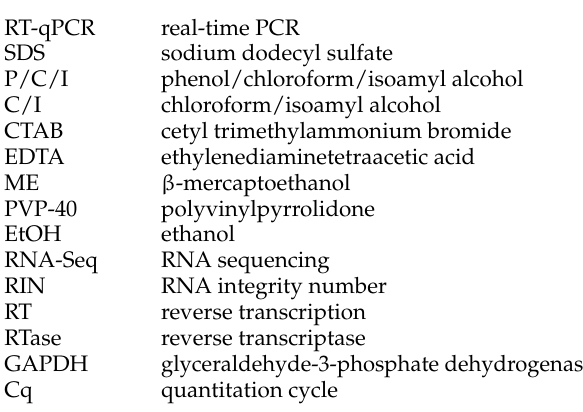
Figure S1: Isolation of hemp bast fibres, Figure S2: Integrity of the purified RNAs, Figure S3: Gel electrophoresis of the RNAs extracted with the four different methods, Table S1: Primers used for the 5 1 -3 1 ratio mRNA integrity test. Acknowledgments: The authors wish to thank Aude Corvisy and Laurent Solinhac for the excellent technical support. The Fonds National de la Recherche, Luxembourg, (Project CANCAN C13/SR/5774202), is gratefully acknowledged for financial